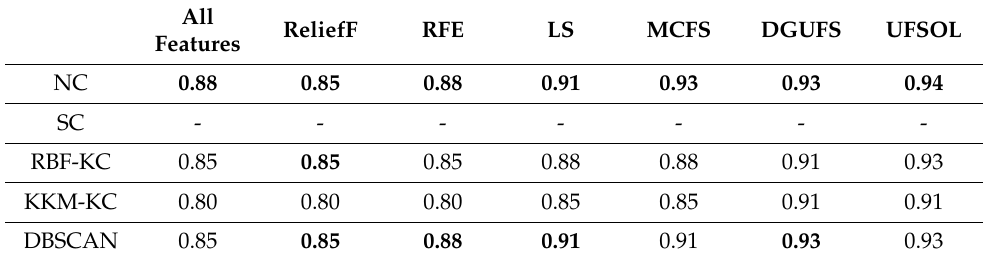
Table 7. Outlier detection precision of clustering algorithms with different feature selection